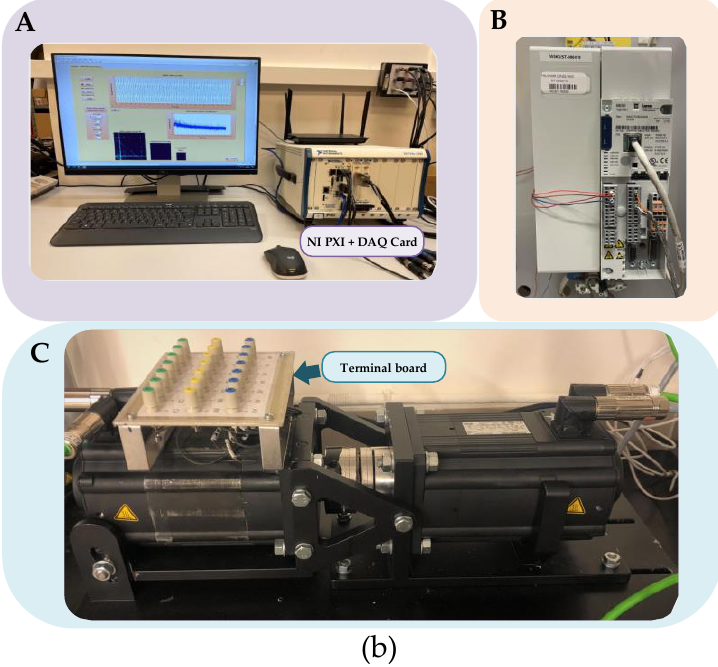
Figure 4. Experimental setup: ( a ) illustrative block diagram; ( b ) real view. A—NI PXI with DAQ card, B—VSI by Lenze, C—motor test bench.